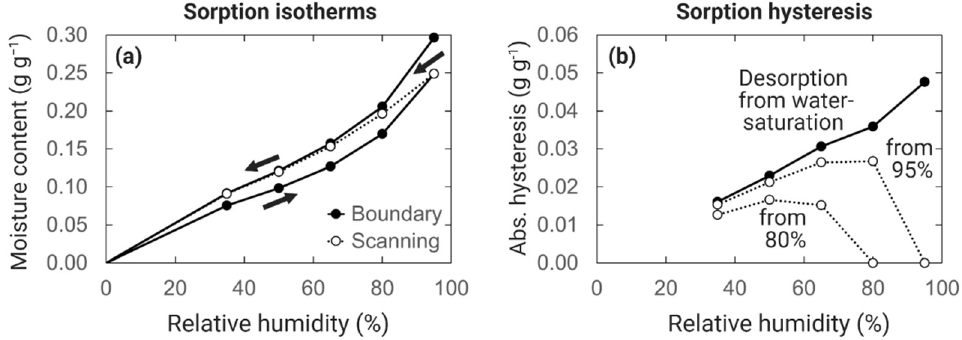
Figure 6. ( a ) Moisture sorption isotherms, and ( b ) absolute hysteresis curves for wood of Norway spruce [174]. Desorption isotherms are determined either from full water saturation (boundary curves) or from conditioning in absorption to either 95% or 80% RH (scanning desorption).